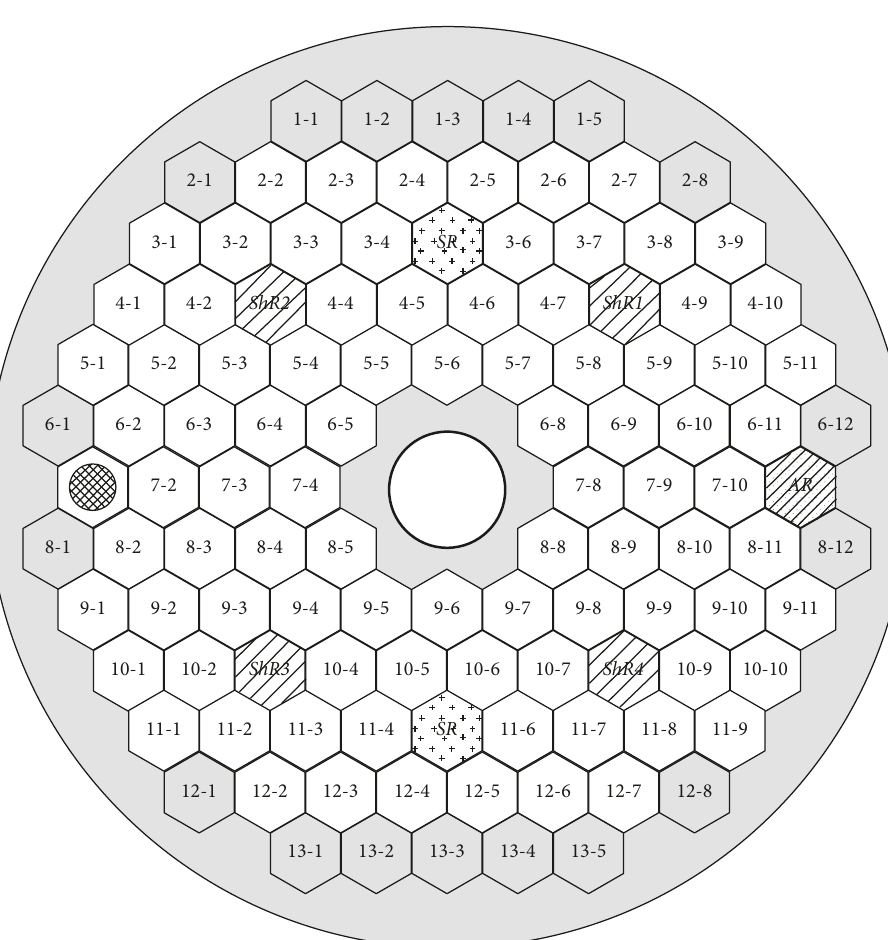
Figure 2: Configuration of the DNRR core with 88 HEU fuel bundles. SR: safety rod, ShR: shim rod, and AR: automatic regulating